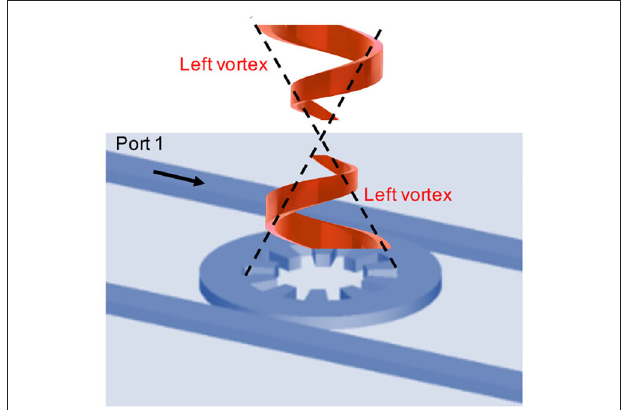
FIGURE 7 | Pancharatnam-Berry-Gouy phase for a vortex generated from the gear. The contribution from the polarization would change the sign of the complex electric field, and the orbital angular momentum will also add to the phase change upon crossing of the focal point. The chirality of a vortex would not be changed upon